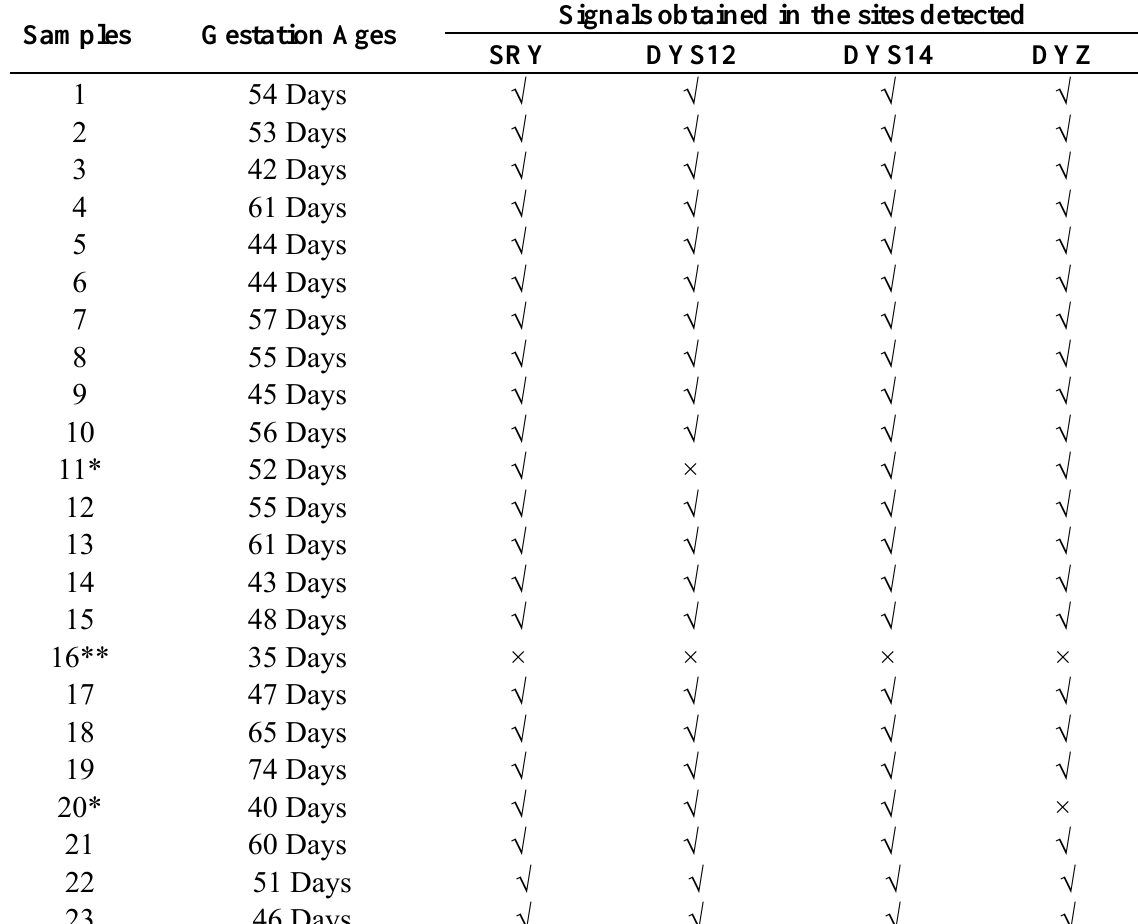
Table 2. Fetal sex identification results of the 23 samples detected by